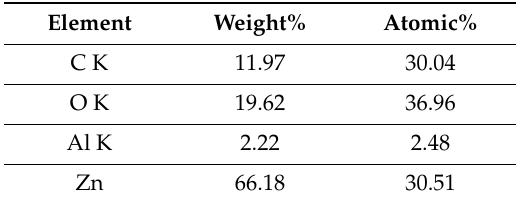
Figure 4. Elemental analysis of ZnO NSs doped with 3 mol % Al. ( A ) SEM mapping images of all the elements. Individual mapping of ( B ) Zn, ( C ) O, ( D ) Al. EDS quantitative and qualitative analysis is shown in ( E ). Table 2. EDX element percentage of each doped sample of Zn-Al 3%.